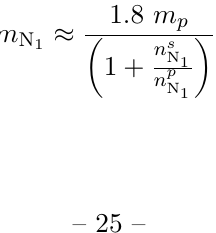
Figure 13 . The accessible parameter space in terms of ξ , ∆ N , and m W and w = 0 (Right Panel). The color shaded areas (with solid line boundaries) present regions that X eq. (5.10) is satisfied while the gray shaded region shows areas associated with The dashed lines present the boundaries corresponding to the same colors but with restricted C2